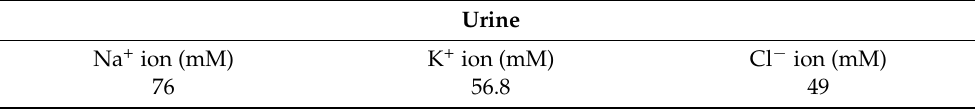
Table 2. Information regarding patient urine sample.